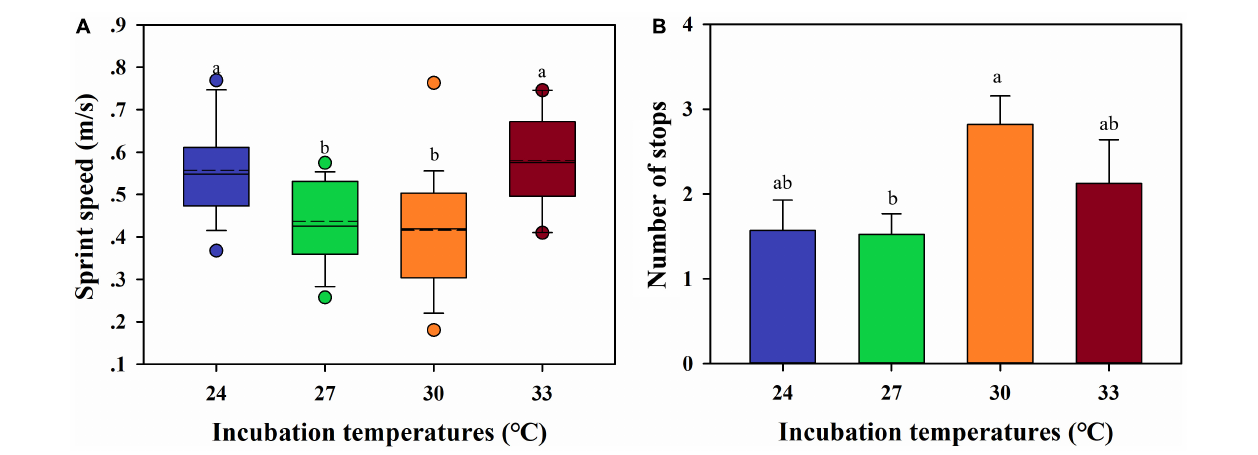
FIGURE 4 | Sprint speed (A) and the number of stops (B) of hatchlings incubated at 24, 27, 30, and 33 ◦ C. (A) The dash lines indicate the mean value of sprint speed; the data are shown as mean ± SE . (A,B) The different letters above the bars indicate the significant differences between incubation temperatures.